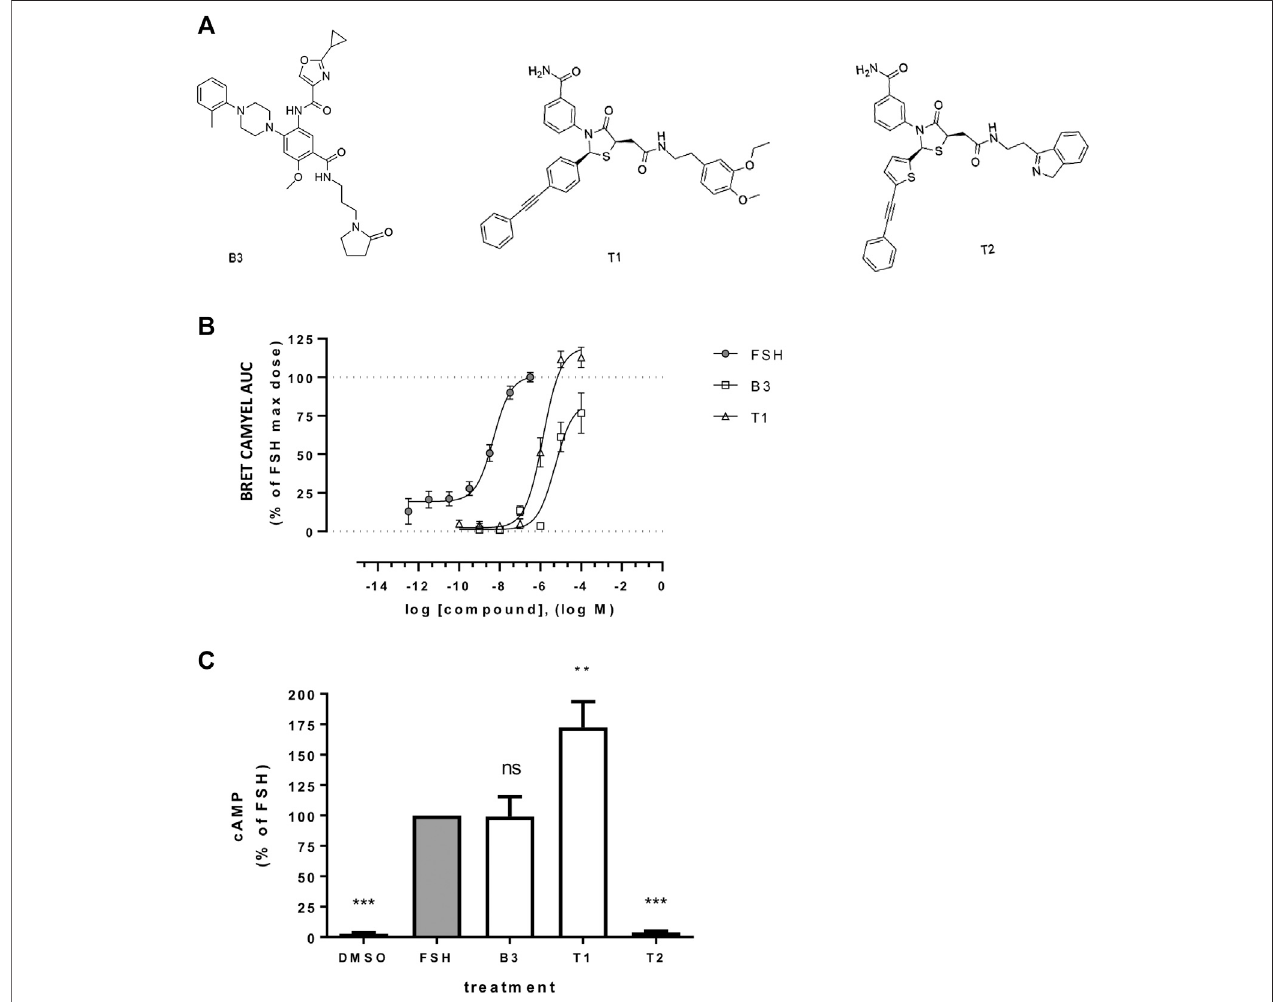
FIGURE 1| Effect of LMW allosteric compounds of FSHR to activate cAMP signaling (A) Chemical structures of compounds used in this study: the benzamide B3 and the thiazolidinone derivates T1 and T2. (B) Intracellular cAMP levels measured in cells transiently transfected with the cAMP BRET sensor CAMYEL and FSHR stimulated with increasing concentrations of FSH, B3 or T1. For each concentration considered, the area under the curve (AUC) was extrapolated from the signal recorded following 20 min stimulation and plotted as concentration/activity curves. Concentrations of FSH were − 12.5 to − 6.5 log M while B3 and T1 were − 10 to − 4 log M, at half-log dilutions. Data were normalized considering FSH maximal response as 100%. n (cid:2) 6 independent experiments. (C) Intracellular levels of cAMP measured via HTRF in cells expressing FLAG-FSHR and stimulation with either DMSO, FSH (10 nM), B3, T1 or T2 (10 μ M) for 5 min. n (cid:2) 4 independent experiments; One-way ANOVA: ** p < 0.01, *** p <